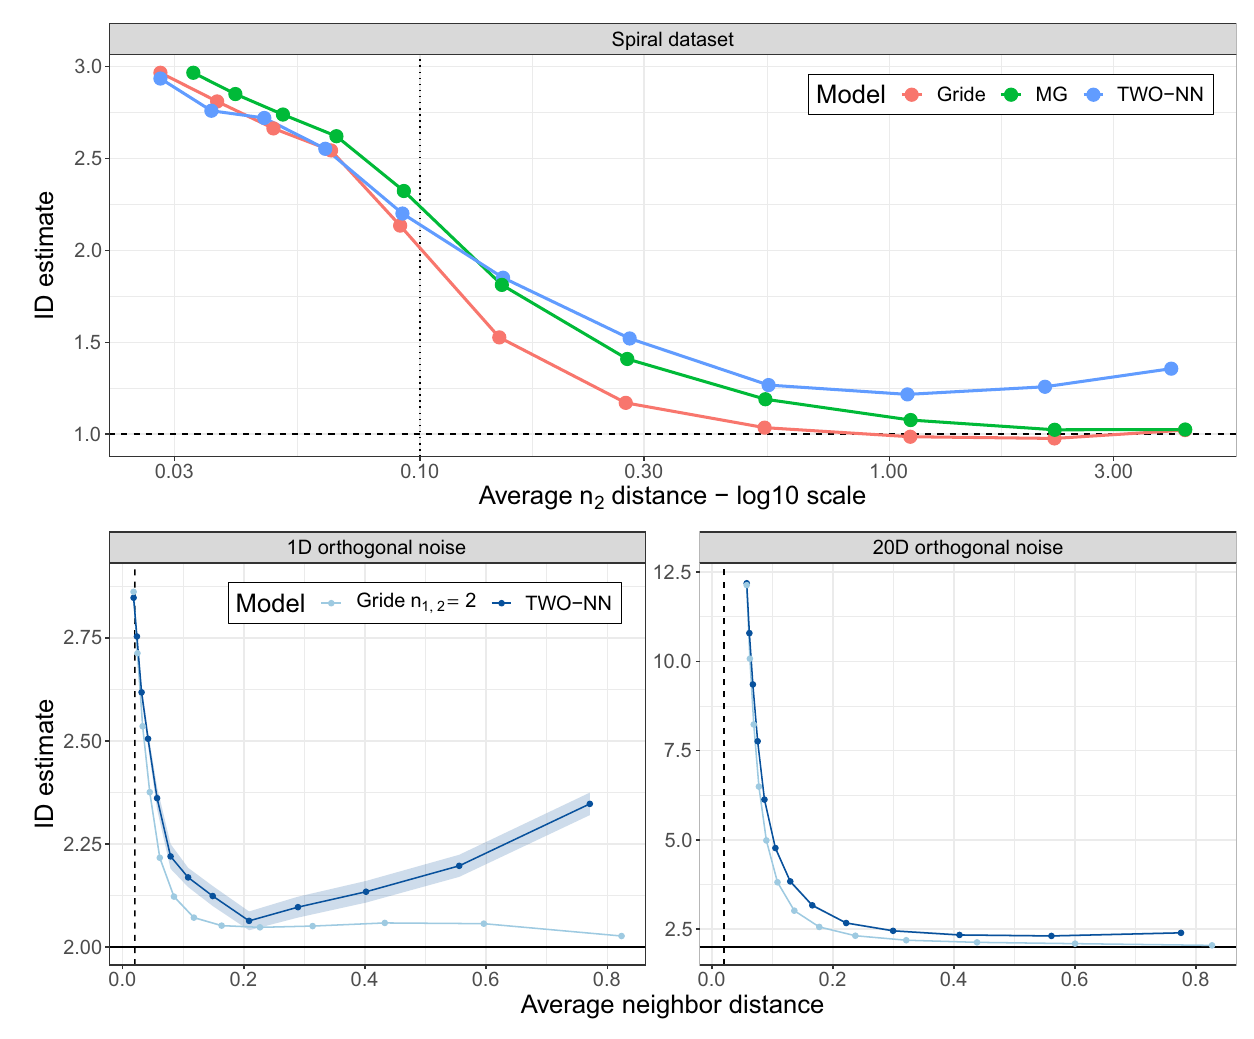
Figure 5. Top panel: study of the evolution of the id on a simulated Spiral dataset. The three lines represent three different models: Gride , MG , and the decimated TWO-NN . Bottom panels: analysis of the impact of the scale on the id estimates comparing Gride models of order ratios n 2,1 performed on a 2D noisy Gaussian dataset. The error bounds (